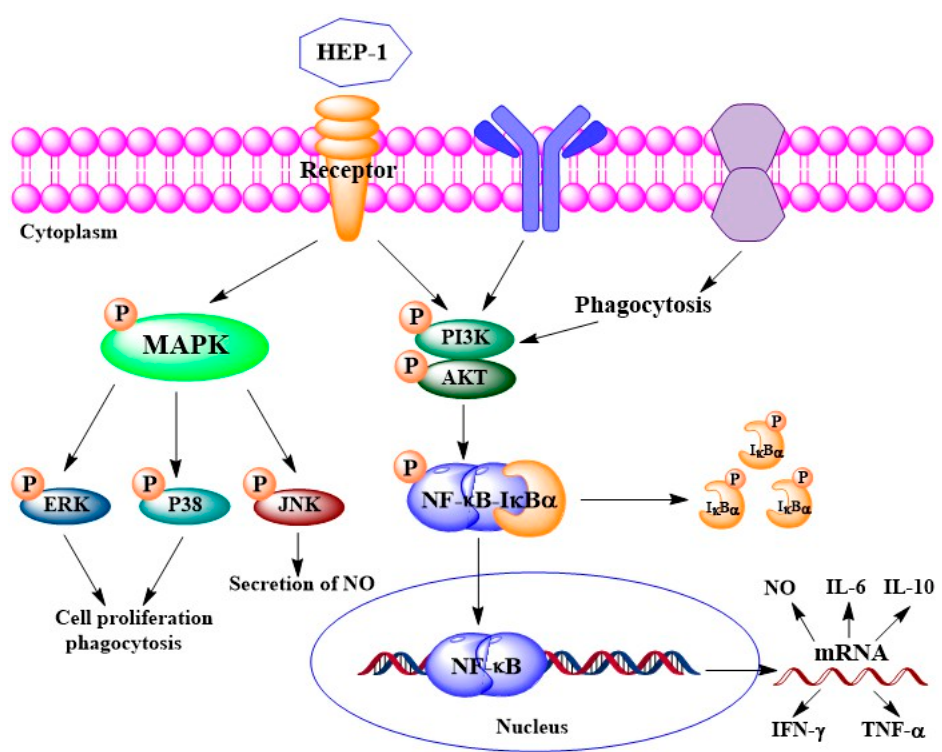
Figure 6. Potential immunomodulatory mechanism for HEP-1-induced macrophage activation.